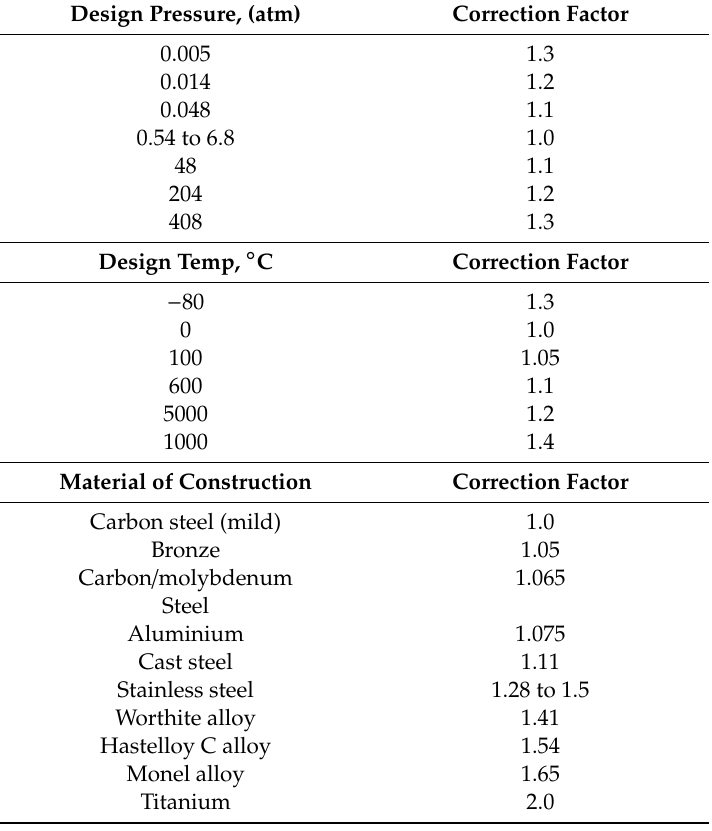
Table 3. Temperature (F T ), pressure (F p ), and material of construction correction factor (F M )